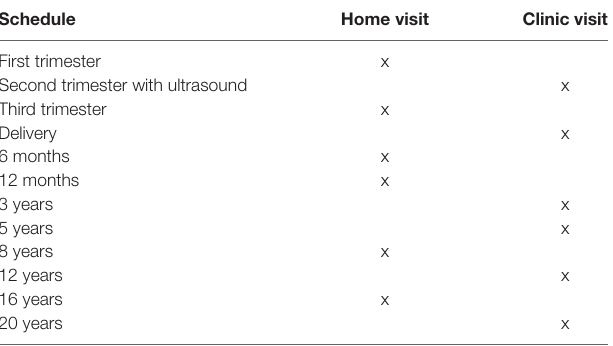
TABLe 1 | National Children’s Study visit schedule as proposed in